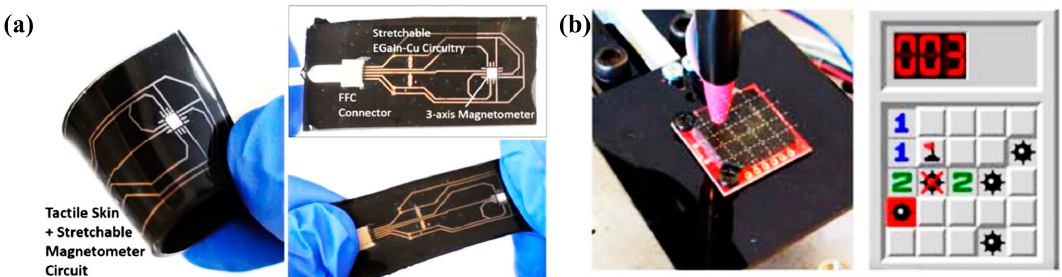
Figure 7. ( a ) Magnetic skin using a mixture of silicone and magnetic particles created by Tess Hellebrekers. Reprinted with permission from Ref. [47]. Copyright 2019, Wiley; ( b ) The scene of applying this array as a sensing device to play a minesweeping game. Reprinted with permission from Ref. [47]. Copyright 2019,